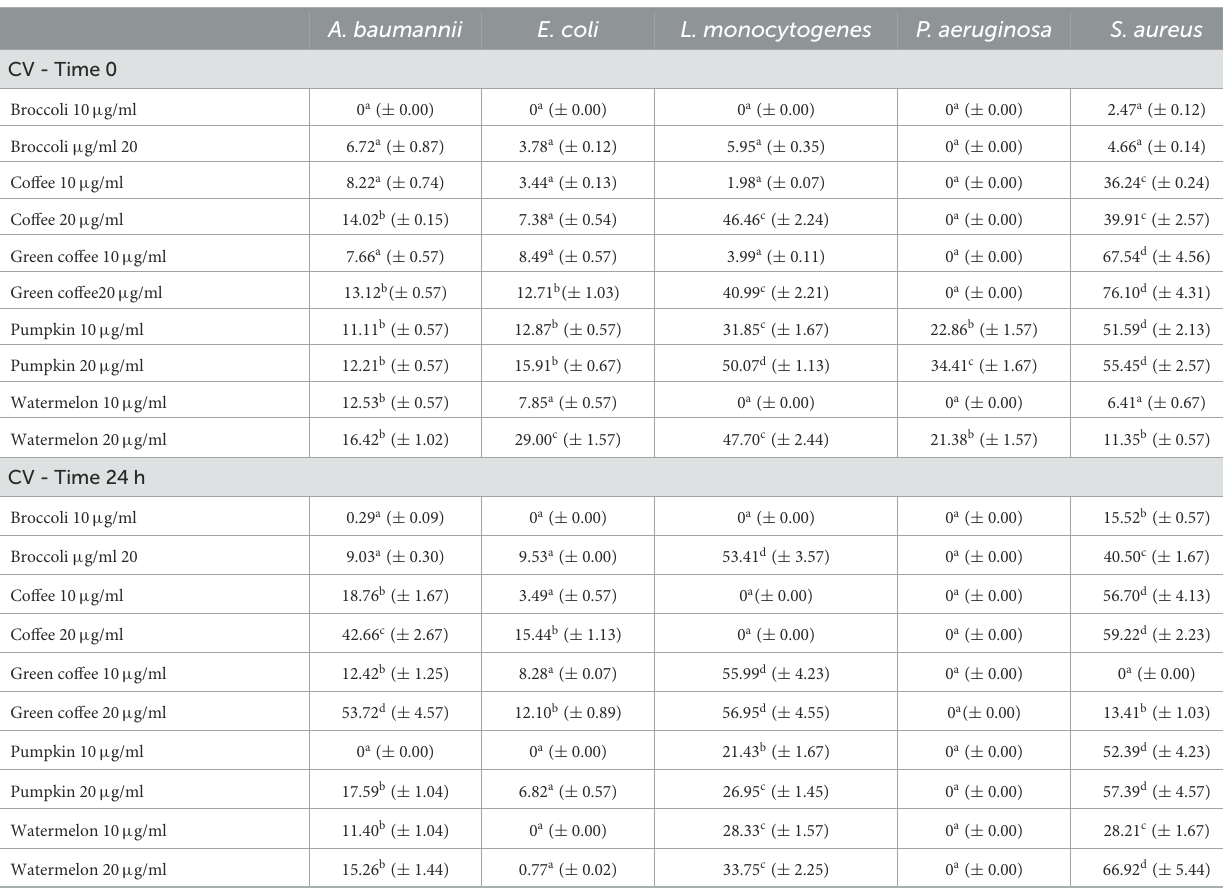
TABLE 4 Inhibitory activity of the seed oils on the bacterial biofilm formation, at 10 and 20 µ g/ml against A. baumannii , E. coli , L. monocytogenes , P. aeruginosa , and S. aureus